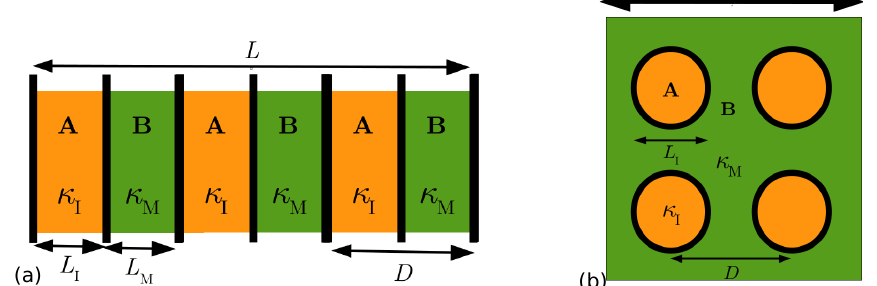
Figure 1. Schematic illustration of: ( a ) a A/B planar superlattice (PSL) structure and ( b ) a nanodot superlattice (NDSL) structure. L represents sample length and D represents size of a unit